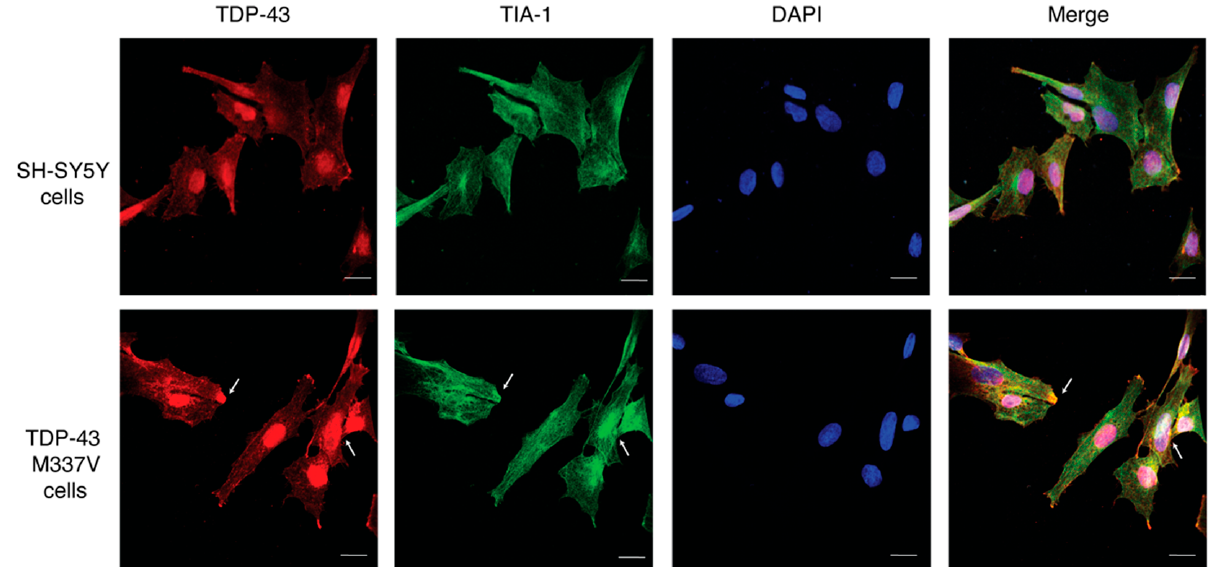
Figure 5. Immunofluorescence imaging of wild–type human neuroblastoma SH-SY5Y cells com- pared to SH-SY5Y cells expressing the ALS–linked mutation TDP-43 M337V. Representative images of SH-SY5Y cells and M337V TDP-43 SH-SY5Y cells showing similar expression levels and distribu- tion of TDP-43 (red), stress granule marker, and TIA-1 (green). DAPI (blue) was used to indicate the nucleus. The arrow shows the colocalisation of TDP-43 and stress granule aggregates. Scale bar = 10 µM.